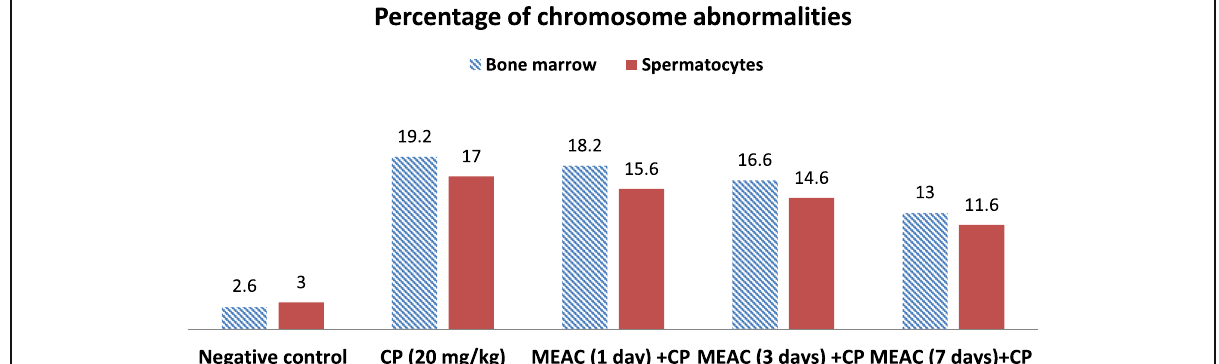
Fig. 2 Frequency of chromosomal abnormalities induced in mouse bone marrow and spermatocytes after treatment with MEAC and CP showed a time-related relationship